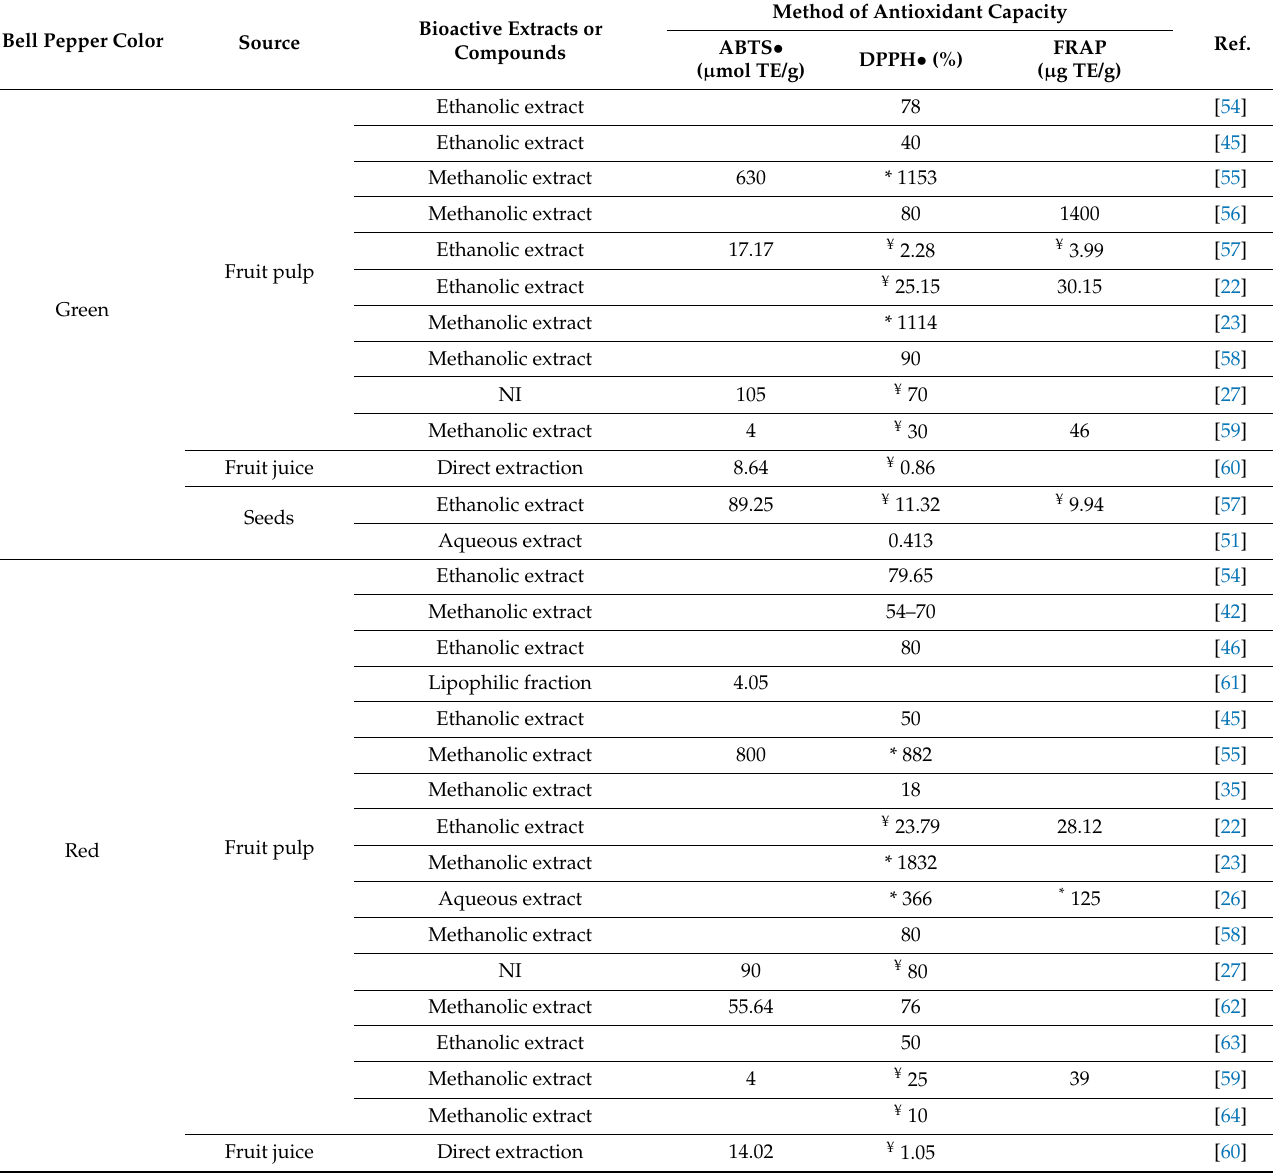
Table 4. Antioxidant capacity by different methods for bell